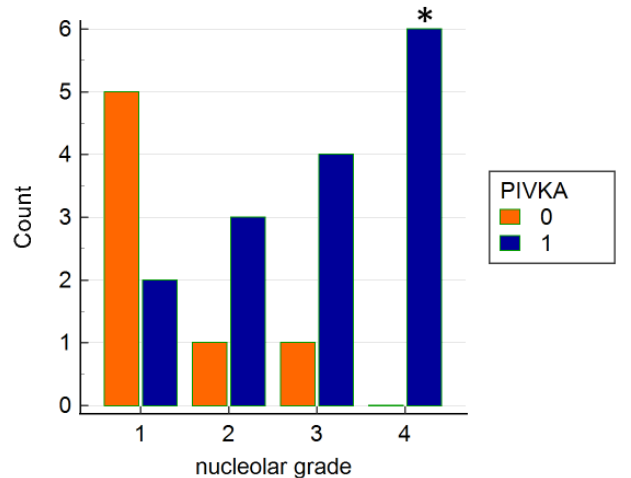
Figure 3. Histogram shows the distribution of positive and negative cases for PIVKA-II in relation to histologic grade relative to nucleolar pleomorphism. * = Fisher’s Exact test p < 0.05.